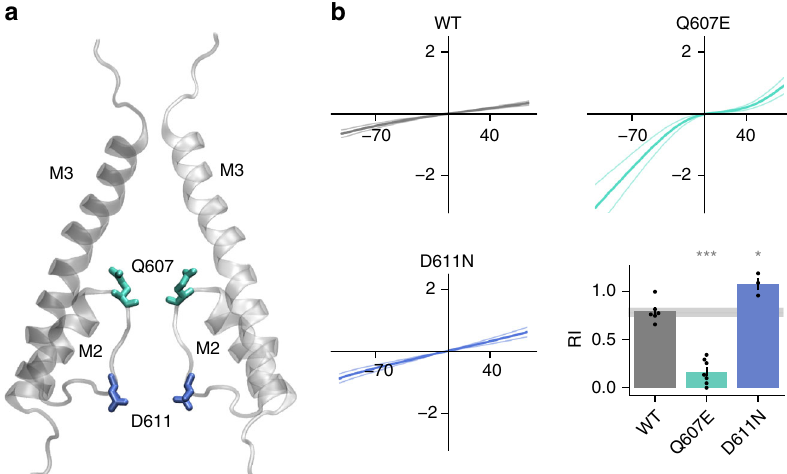
Fig. 7 Changes at the polyamine binding site alter recti fi cation in GluA2 homomeric channels. a Pore detail of 2 opposing subunits in GluA2 tetramer (cryo- EM structure pdb 6dm0). b Ramps were applied to HEK cells expressing homomeric GluA2 channels and recti fi cation quanti fi ed as for Fig. 4 (* p < 0.05, ** p < 0.01, *** p < 0.001). Number of cells recorded per mutant: WT:6, Q607E:7,